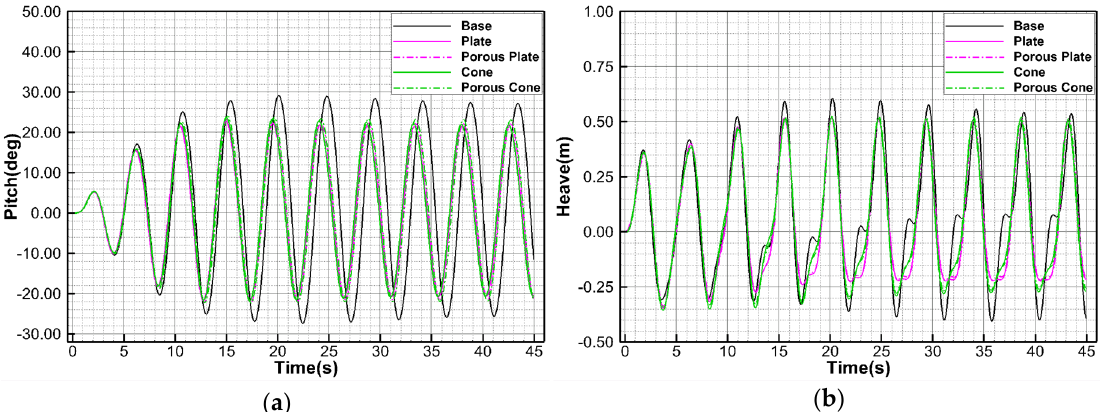
Figure 17. Time histories of ( a ) pitch and ( b ) heave motions of the buoys in regular waves, for which the frequency is the same as the pitch natural frequency of the Base model, estimated by CFD simulation.